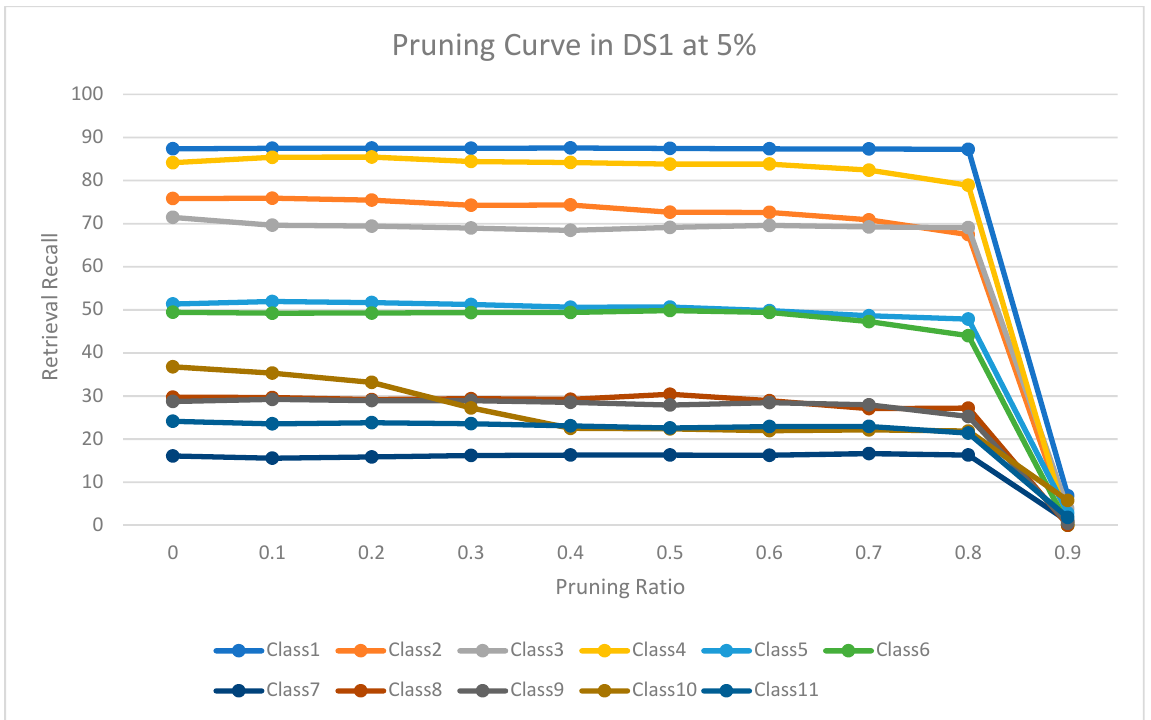
Figure 4. The level of retrieval recall values at different percentages of pruning at the top 1% in MDDR-DR1.